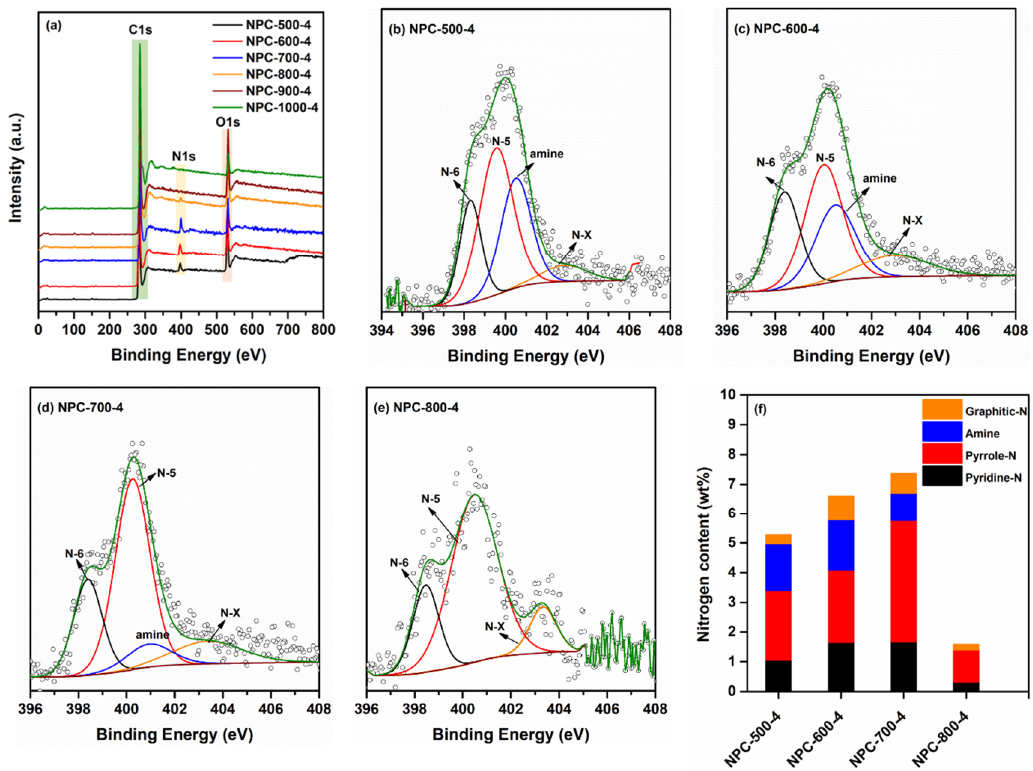
Figure 2. XPS ( a ), N1s XPS ( b – e ) spectra of NPC-y-4, and the contents of the nitrogen group in NPC-y-4 ( f ). Table 1. Elemental analysis data for RSS and NPCs.